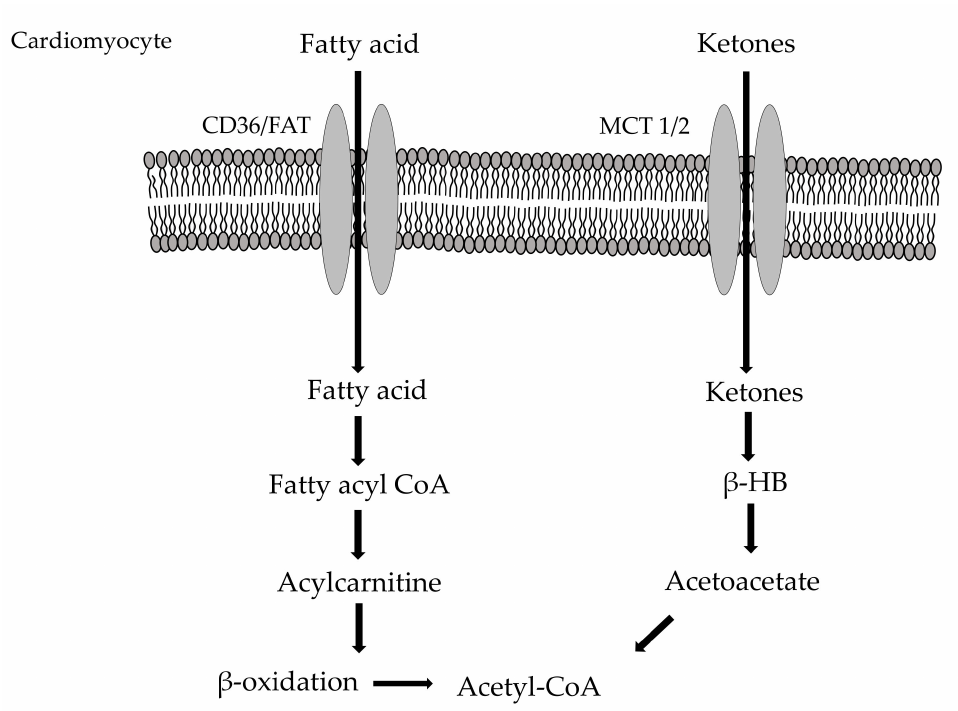
Figure 3. Cardiometabolism of fatty acids and ketones. CD36/FAT: Fatty Acid Transport proteins; MCT 1/2: Monocarboxylate Transporter; β -HB: β